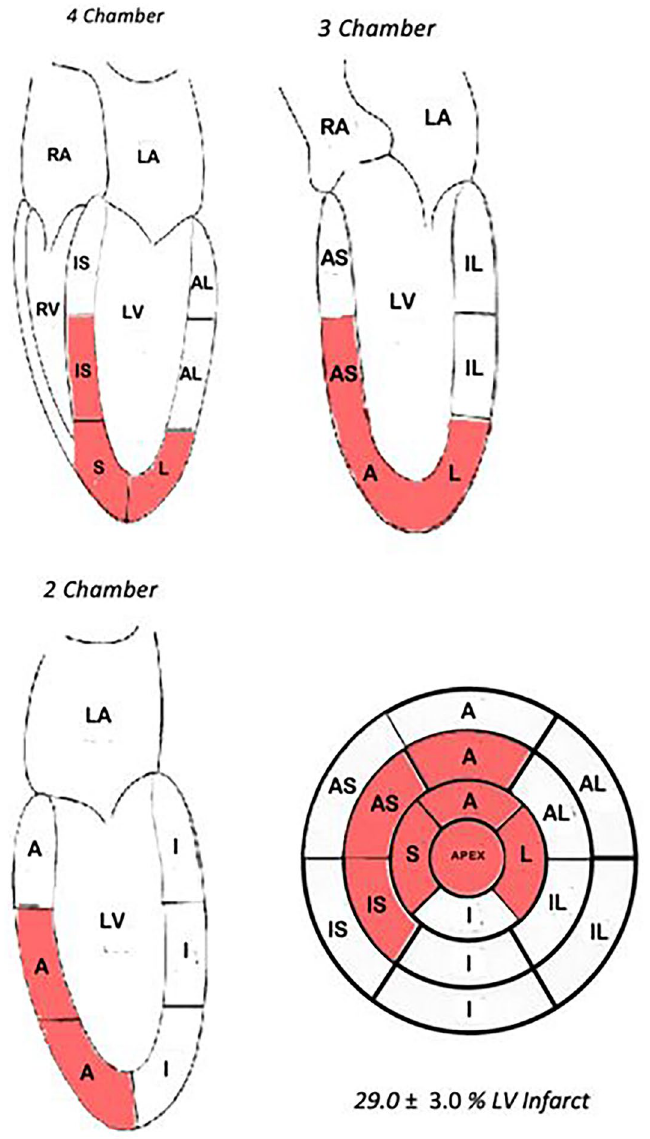
shows the apex at center most portion of the wheel and the base segments at the outermost portion of the wheel. Segments with myocardial ischemic injury are shown in red. The average estimated infarct percent volume (%) is denoted below the 17-segment